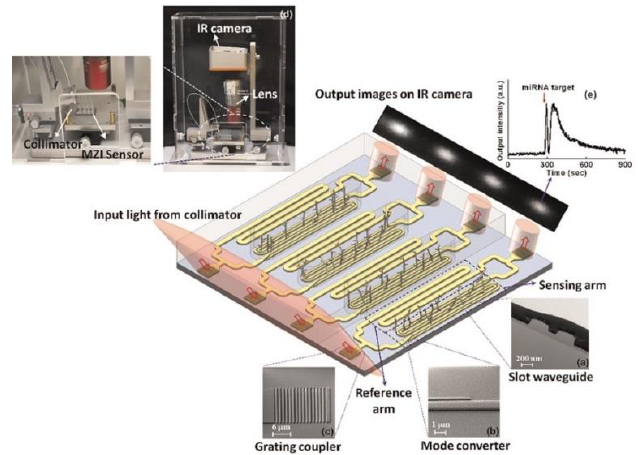
Figure 15. Schematic diagram of the MZI biosensor platform ( a ) TEM image of the cross section of the waveguide. ( b ) SEM images of mode converter, and ( c ) a silicon nitride grating coupler. ( d ) Photograph image of MZI biosensor. ( e ) Output intensity displaying a 4 π phase shift after the target miRNA recognition. Reproduced with permission from [31]. Copyright Elsevier, 2015.